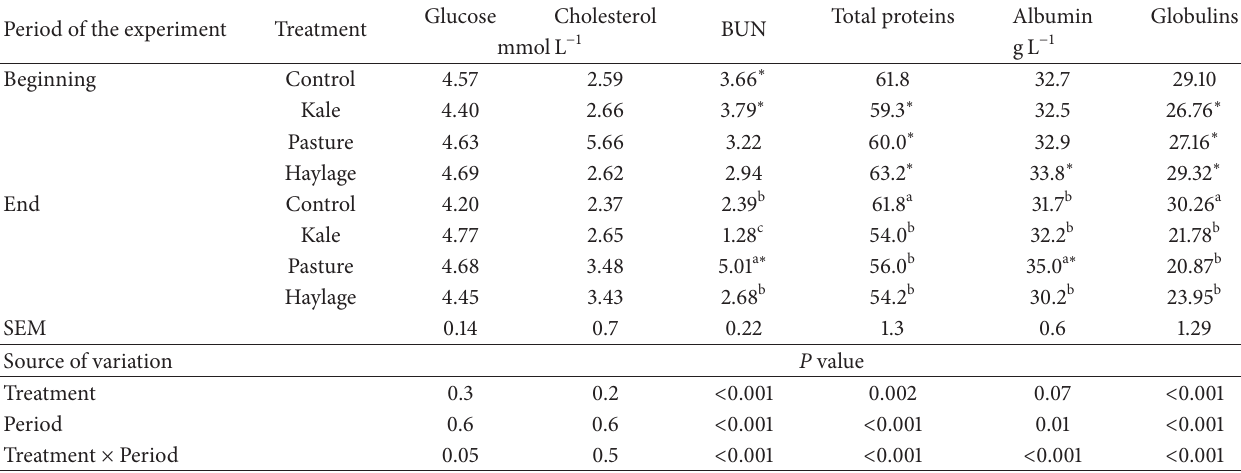
Table 3: Blood parameters at the beginning and the end of the experiment for calves fed a control hay diet with 1kg of barley daily (Control), a 50% kale/50% haylage based diet (Kale), management intensive grazing (Pasture), or a grass haylage based diet (Haylage). Period of the